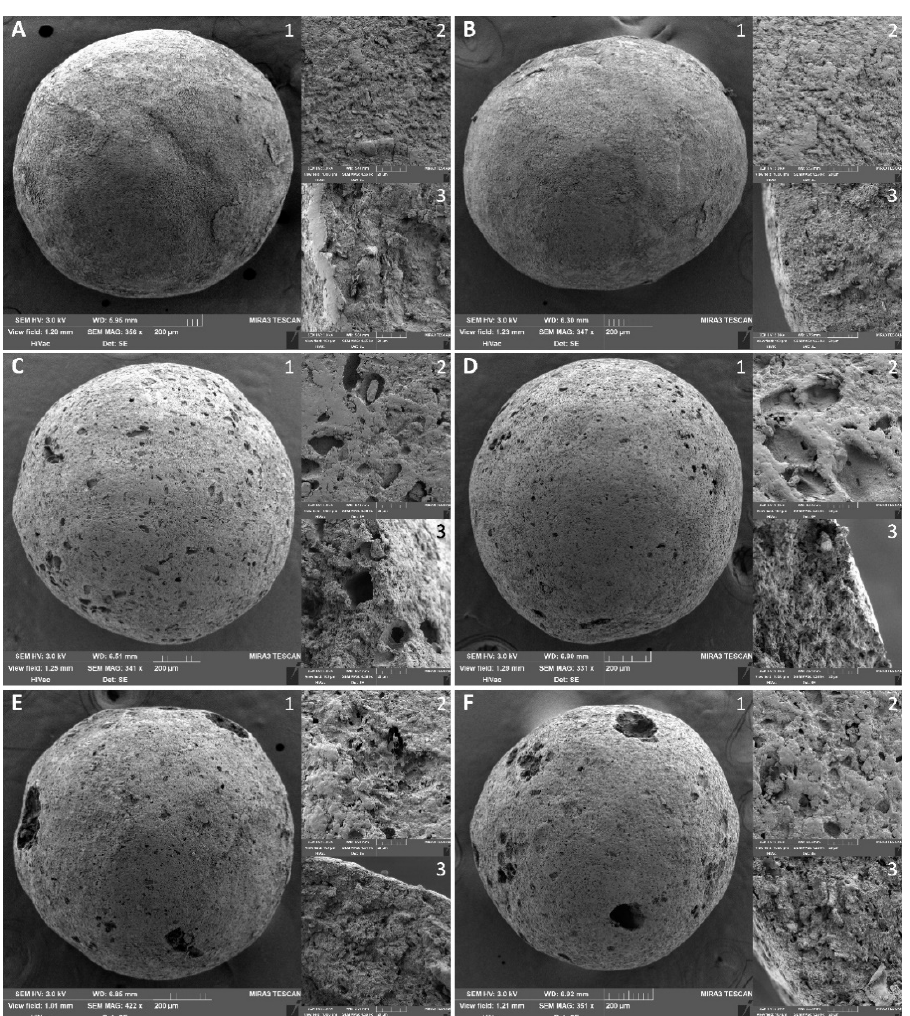
Figure 2. SEM images of pellets: ( A )—reference pellet (N) with no camphor or menthol; ( B )—reference pellet, impregnated with PY-OPD; ( C )—M20.0; ( D )—M20.0 impregnated with PY-OPD; ( E )—C20.0; ( F )—C20.0 impregnated with PY-OPD; 1—whole pellet, 2—surface detail; 3—cross-section detail.